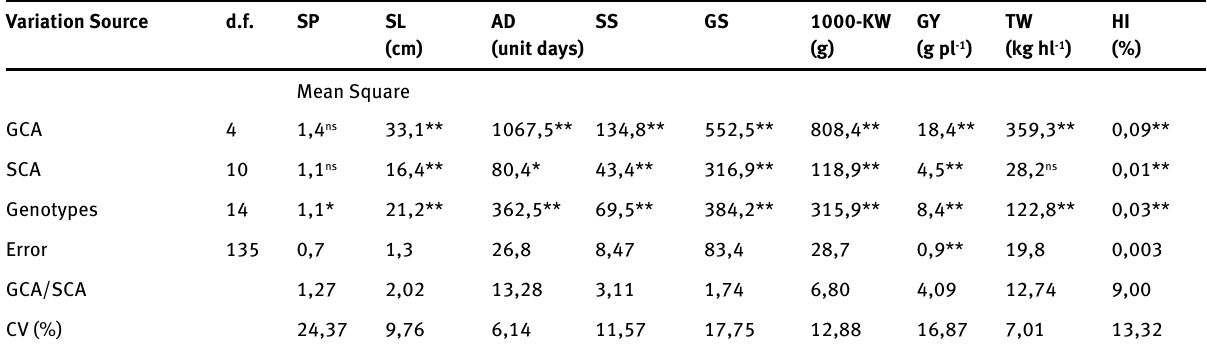
GCA = general combining ability; SCA = specific combining ability; CV = percent coefficient of variation; df = degrees of freedom; SP = spikes per plant; SL = spike length, AD = days to anthesis; SS = spikelets per spike; GS = grains per spike; 1000-TW = 1000-kernel weight;